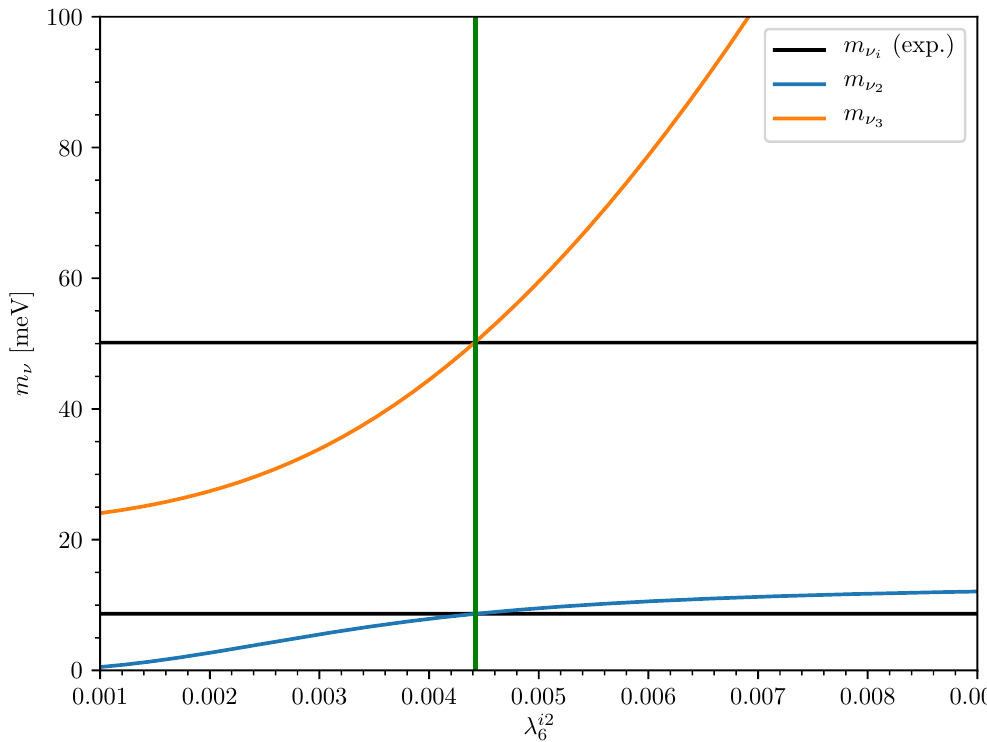
Figure 5 . Neutrino masses m (cid:23) i in the model T1-3-B ( (cid:11) = 0) with two generations of scalar triplets as a function of (cid:21) i 2 . The used parameters are given in table 2. The experimentally determined 6 neutrino masses are reproduced for (cid:21) i 2 = 0 : 6